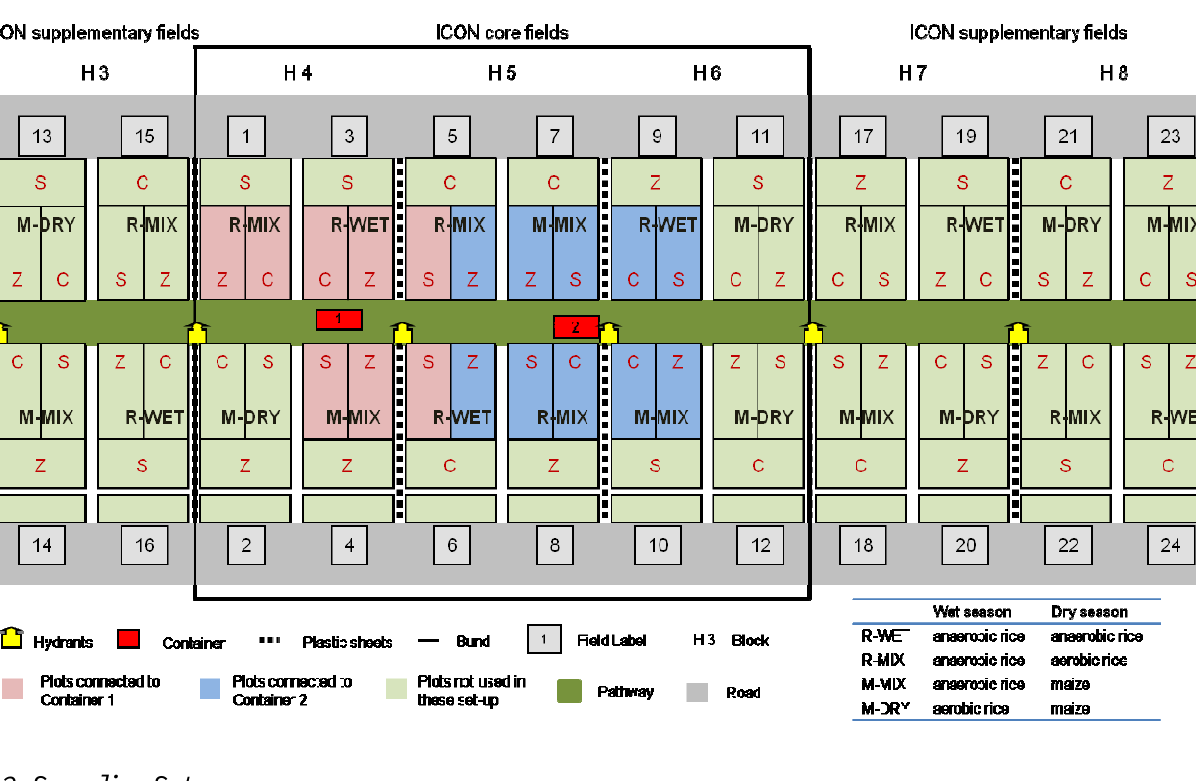
Figure 1. ICON experimental field design with core and supplementary fields. Each contain twelve fields with four crop rotations triplicated and three different nitrate fertilizer treatments (Z = zero-N, S = site-specific and C = conventional). Two containers house the sampling system and analytical devices. Pink shaded fields are connected to the system in container one and blue fields to the system in container two. Fields are separated by bunds or plastic sheets inserted 0.3 m into the